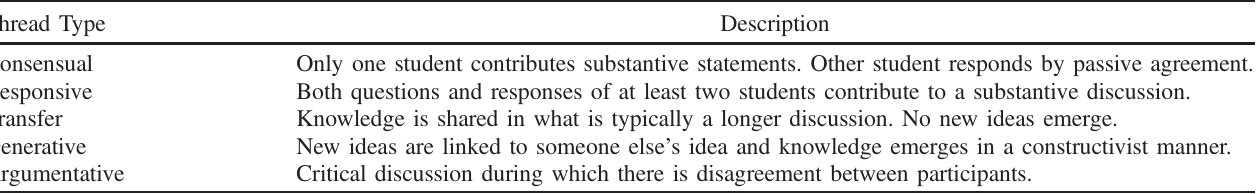
TABLE III. Framework used to code NB threads.